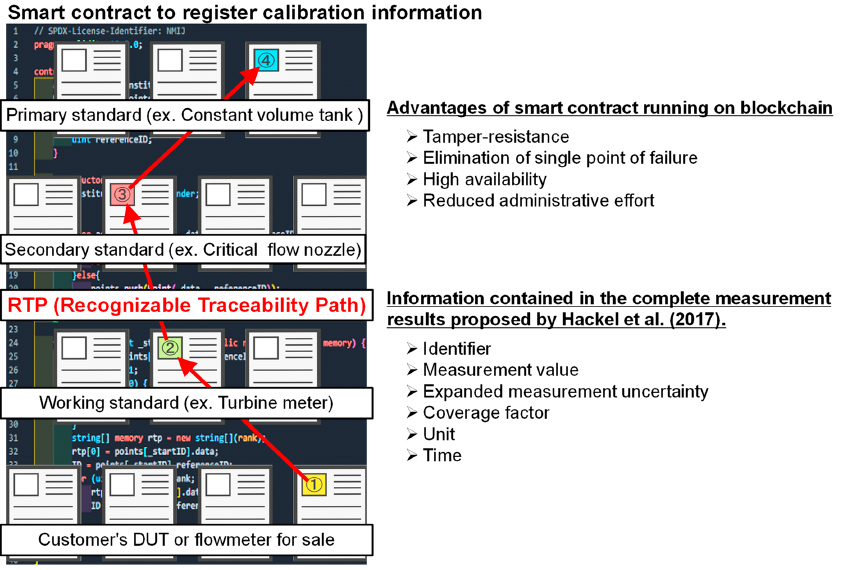
Figure 1. Conceptual diagram of the RTP using a smart contract. Hackel et al. [9] mentioned the necessary content for DCC.